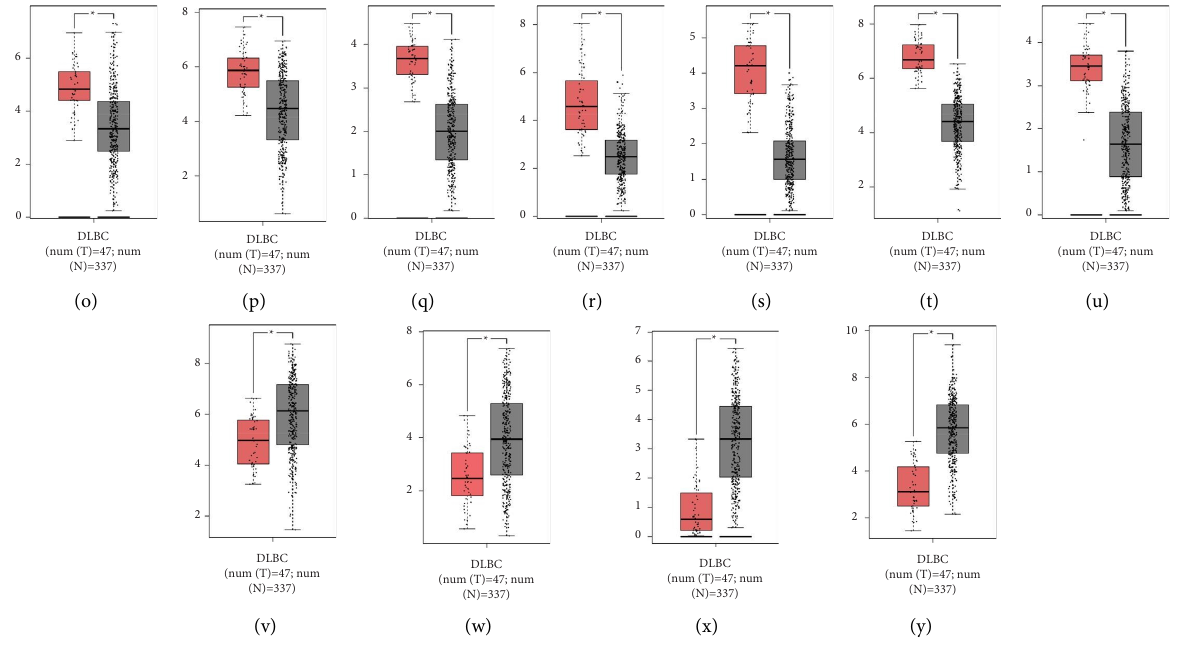
Figure 9: GEPIA database analyzed mRNA expression levels associated with target genes that participated in NF-kappa B signaling pathway. (a–u) TRAF5, ATM, BCL2, BCL10, BIRC2, CD40, CXCL12, DTL, IRAK1, MALT1, MAP3K7, NFKB1, PARP1, PLAU, PLCG1, SYK, TAB1, TRAF1, TRAF3, UBE2I, and XIAP were signifcantly increased in DLBCL. (v–y) MYD88, TLR4, TNFSF14 and TRIM25, notably, decreased in DLBCL. Te red color represents DLBCL samples, and the gray color represents normal control samples. ∗ P <